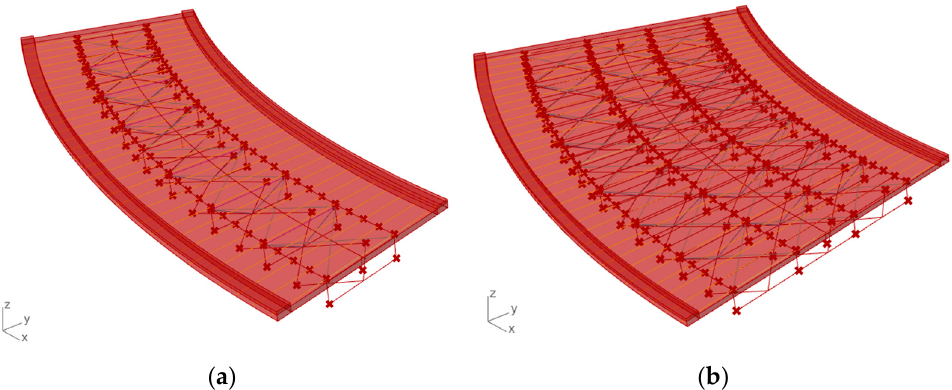
Figure 5. Girder parametric variations : ( a ) double girder geometrical model; ( b ) four-girder bridge model.